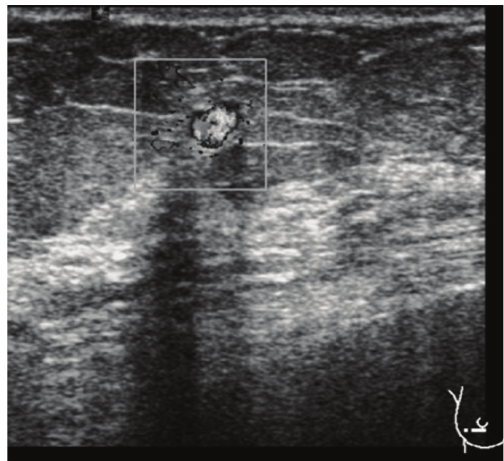
Figure 1: Hypoechoic, mass with lobular contours is observed hypervascular on color Doppler US at the lower outer quadrant at the right